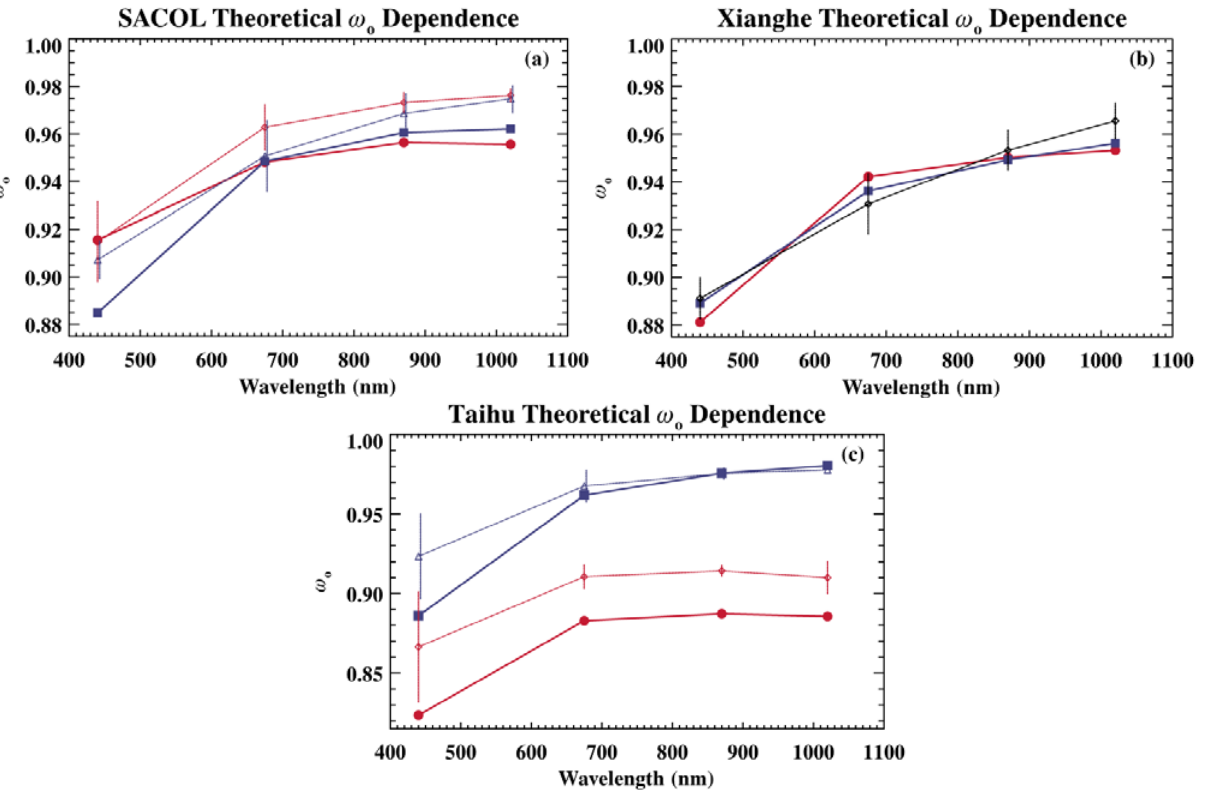
Figure 6. ( a ) Comparison between the observed (solid) and theoretically calculated (dashed) ω for the winter (red circle) and spring (blue box) cases at SACOL, ( b ) Xianghe, o and ( c ) Taihu. The measured complex index of refraction and the effective radii were used as inputs of the model calculation where the complex index of refraction is held constant while the effective radius